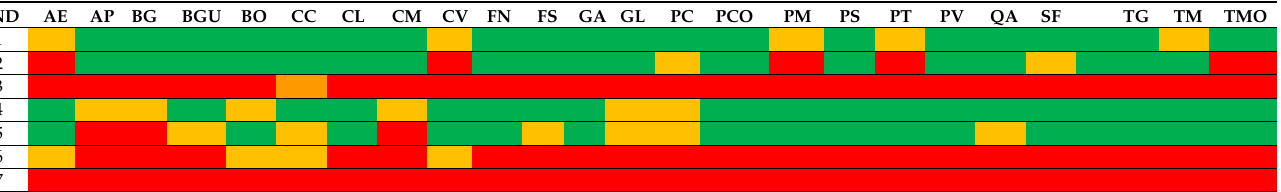
Table 4. Results obtained for the Biodiversity indicators of the different UFs.